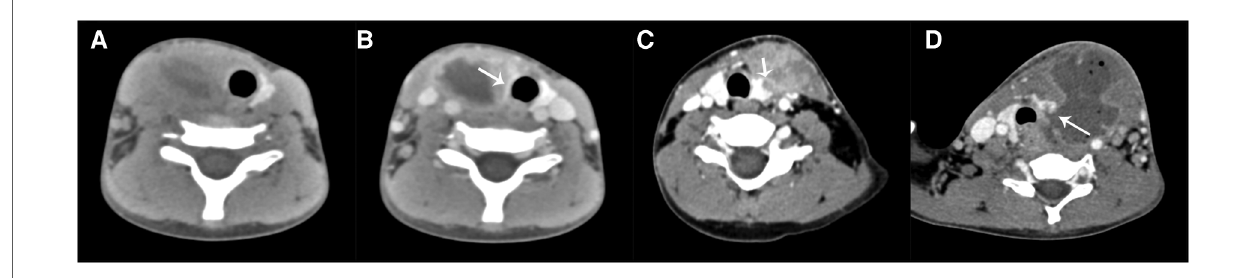
FIGURE 1 ( A,B ) A 4-year-old girl had a right neck mass for 5 days. ( A ) CT plain scan showed a soft tissue mass in front of the right neck with necrotic lesions. ( B ) Contrast-enhanced CT showed abscess wall thickening and annular enhancement; the right lobe of the thyroid presented a low-density shadow and unclear boundary (arrow). The trachea and carotid sheath were displaced. ( C ) A 6-year-old boy had a left neck mass for 14 days. Contrast-enhanced CT showed a soft tissue mass in the front of the left neck with uneven enhancement; the left lobe of the thyroid was involved with the low-density shadow extending to the mass (arrow). ( D ) A 9-year-old boy had a left neck mass with a fever for 4 days. Contrast-enhanced CT showed the formation of a left anterior cervical abscess, accompanying gas accumulation, displacement of trachea and carotid sheath, and stenosis of the left internal jugular vein; the left lobe of the thyroid and the posterior pharyngeal wall were involved with the low-density shadow extending to the abscess (arrow).